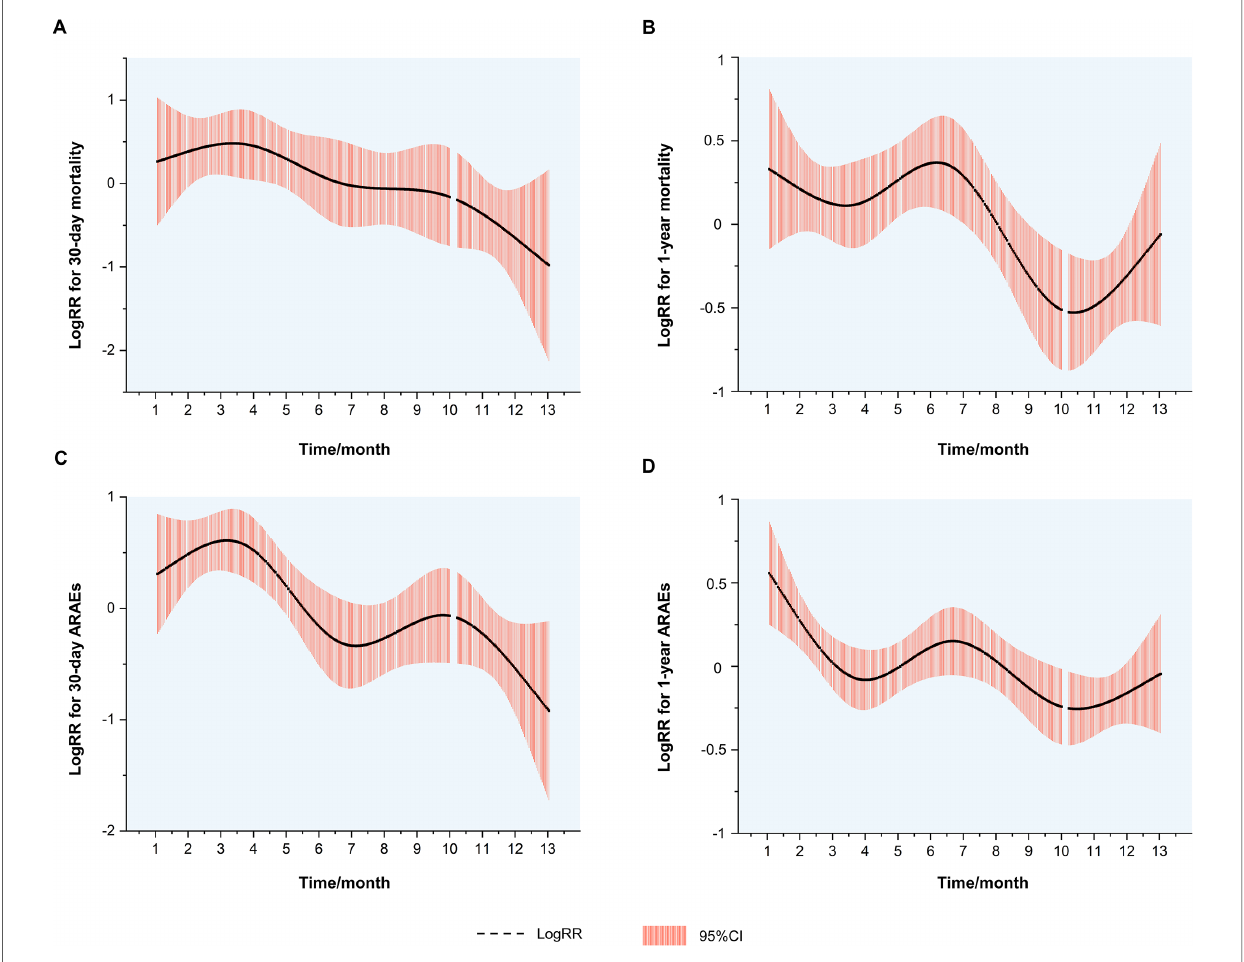
FIGURE 3 Kaplan – Meier curves. ( A ) Kaplan – Meier curves for the 30-day mortality. ( B ) Kaplan – Meier curves for the 1-year mortality. ( C ) Kaplan – Meier curves for the 30-day ARAEs. ( D ) Kaplan – Meier curves for the 1-year ARAEs. ARAEs, aortic-related adverse